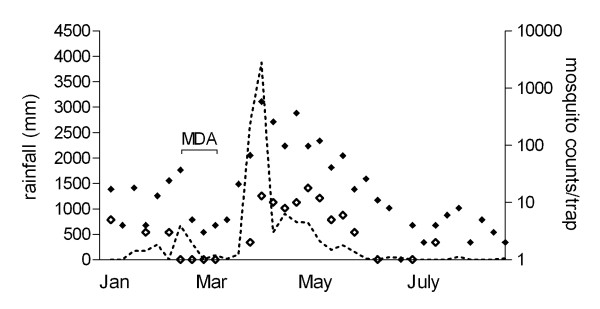
Seasonality, entomology and timing of the intervention. Rainfall data is given in the dashed line in mm/week; the average number of female anophelines caught per night in five sentinel houses in Kiruani is represented by solid diamonds; the average number of female anophelines caught per night in ten sentinel houses in Magadini and Korongo is represented by open diamonds. The drug intervention was completed 3-5 weeks before the start of the rains in early April.